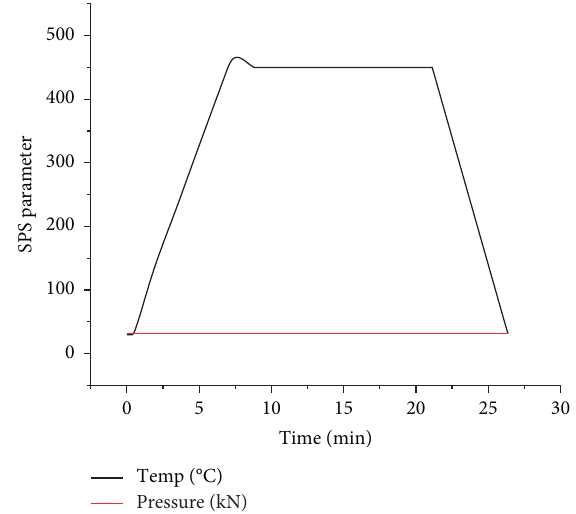
Figure 4: SPS parameter variation with